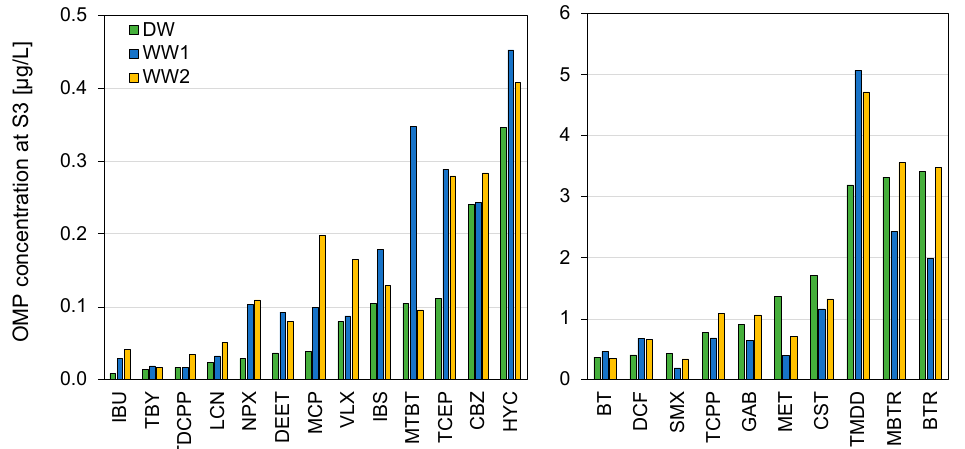
Figure A2. Concentrations of 23 organic micropollutants of dry- (n = 1) and wet-weather sampling (n = 2) at the effluent of the GAC filter (S3).